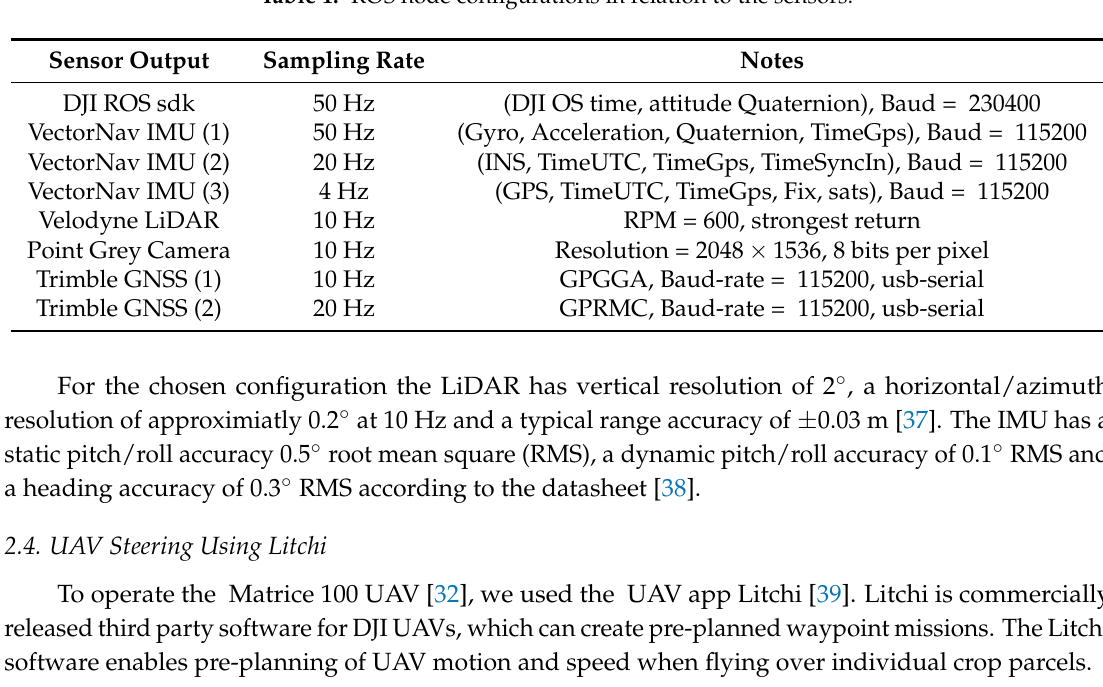
Table 1. ROS node configurations in relation to the